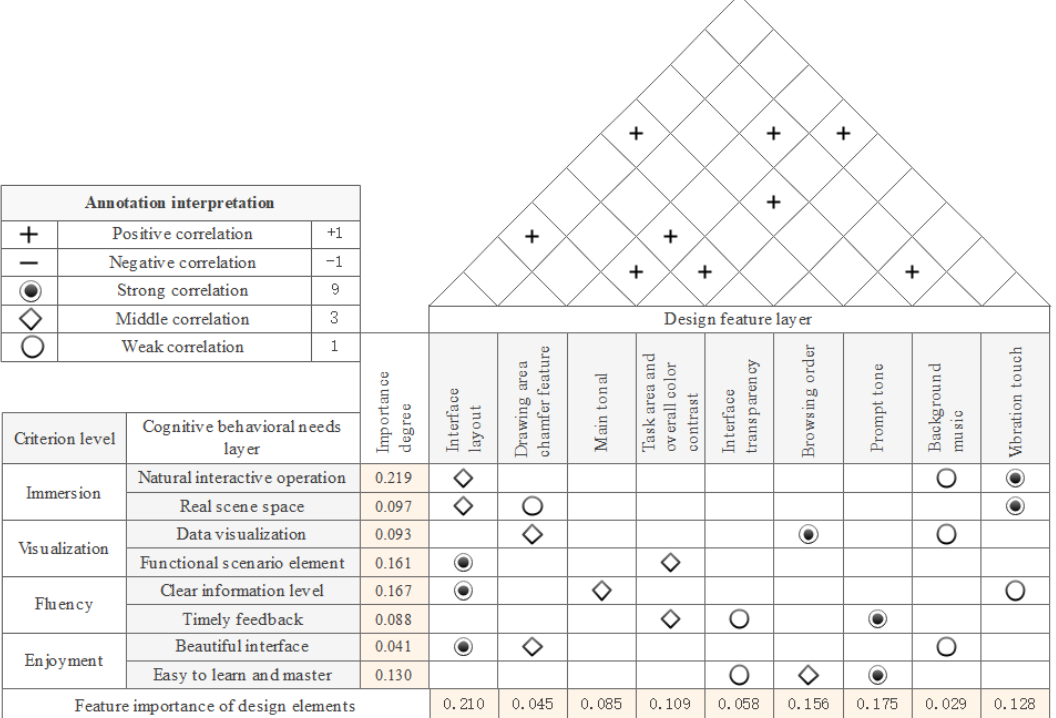
Table 13. Virtual reality (VR) information interface scenario design element table.